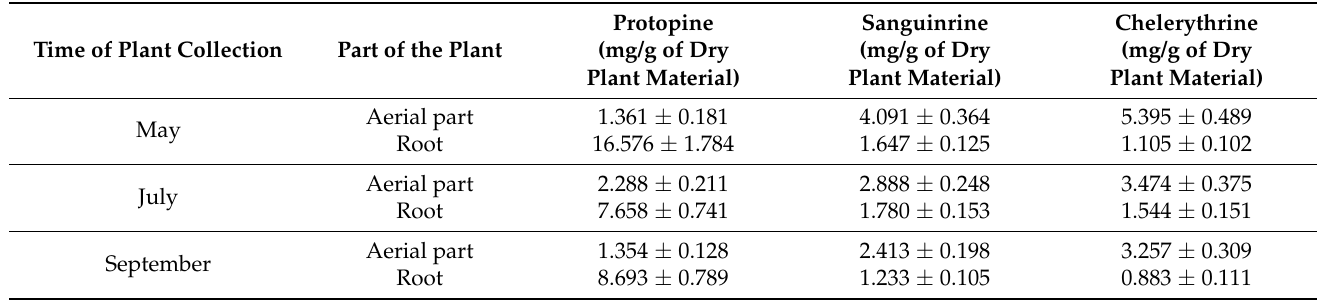
Table 1. Content of isoquinoline alkaloids in the plant extracts and the standard deviation of these values.